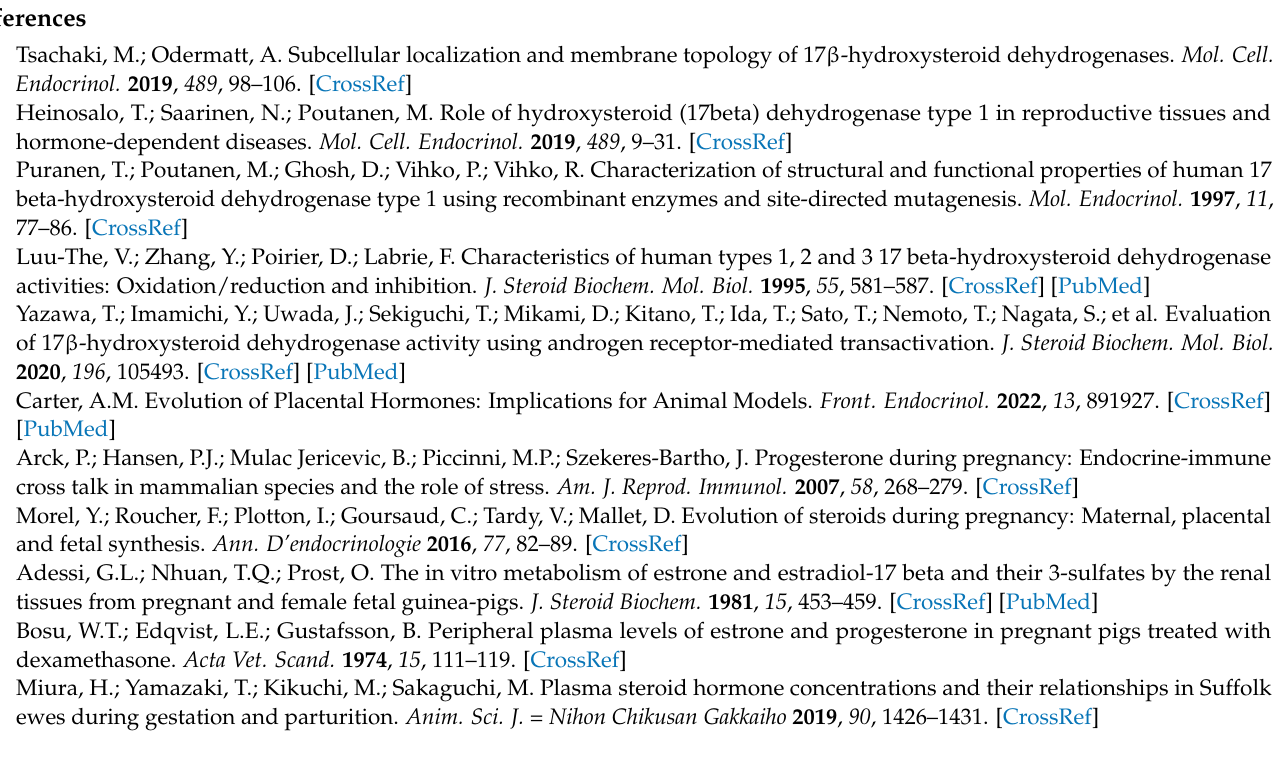
in Figure 2; Figure S2: The whole images of Western blot analyses in Figure 4A; Table S1: Primers used in each